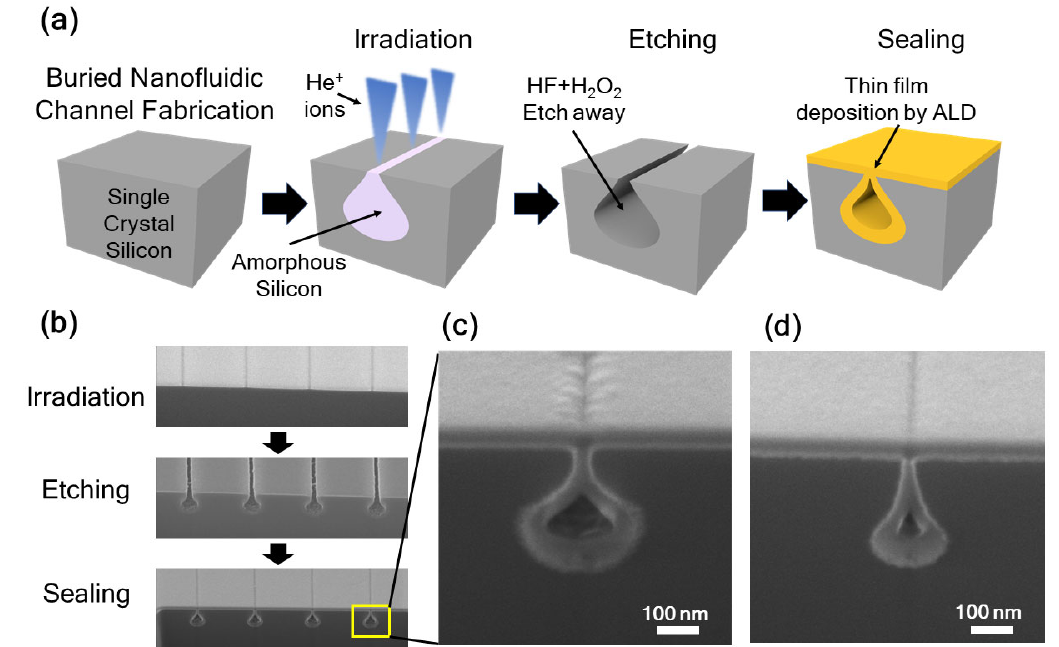
Figure 5. ( a ) Schematics of the process of fabricating buried Si nanofluidic channels using HIBEE. ( b ) SEM images of single-crystal Si undergoing helium ion beam line irradiation, etching, and atomic layer deposition of SiO 2. ( c ) Zoomed-in cross-sectional view of a sealed and buried Si nanofluidic channel produced by a rectangle dose of 10 µ m × 10 nm with an influence of 31,205 ions/nm 2 . ( d ) Zoomed-in cross-sectional view of a sealed and buried Si nanofluidic channel with a smaller diameter and a different shape obtained by tuning the HIBEE processing parameters. A rectangle dose of 10 µ m × 10 nm area size with an influence of 6241 ions/nm 2 was